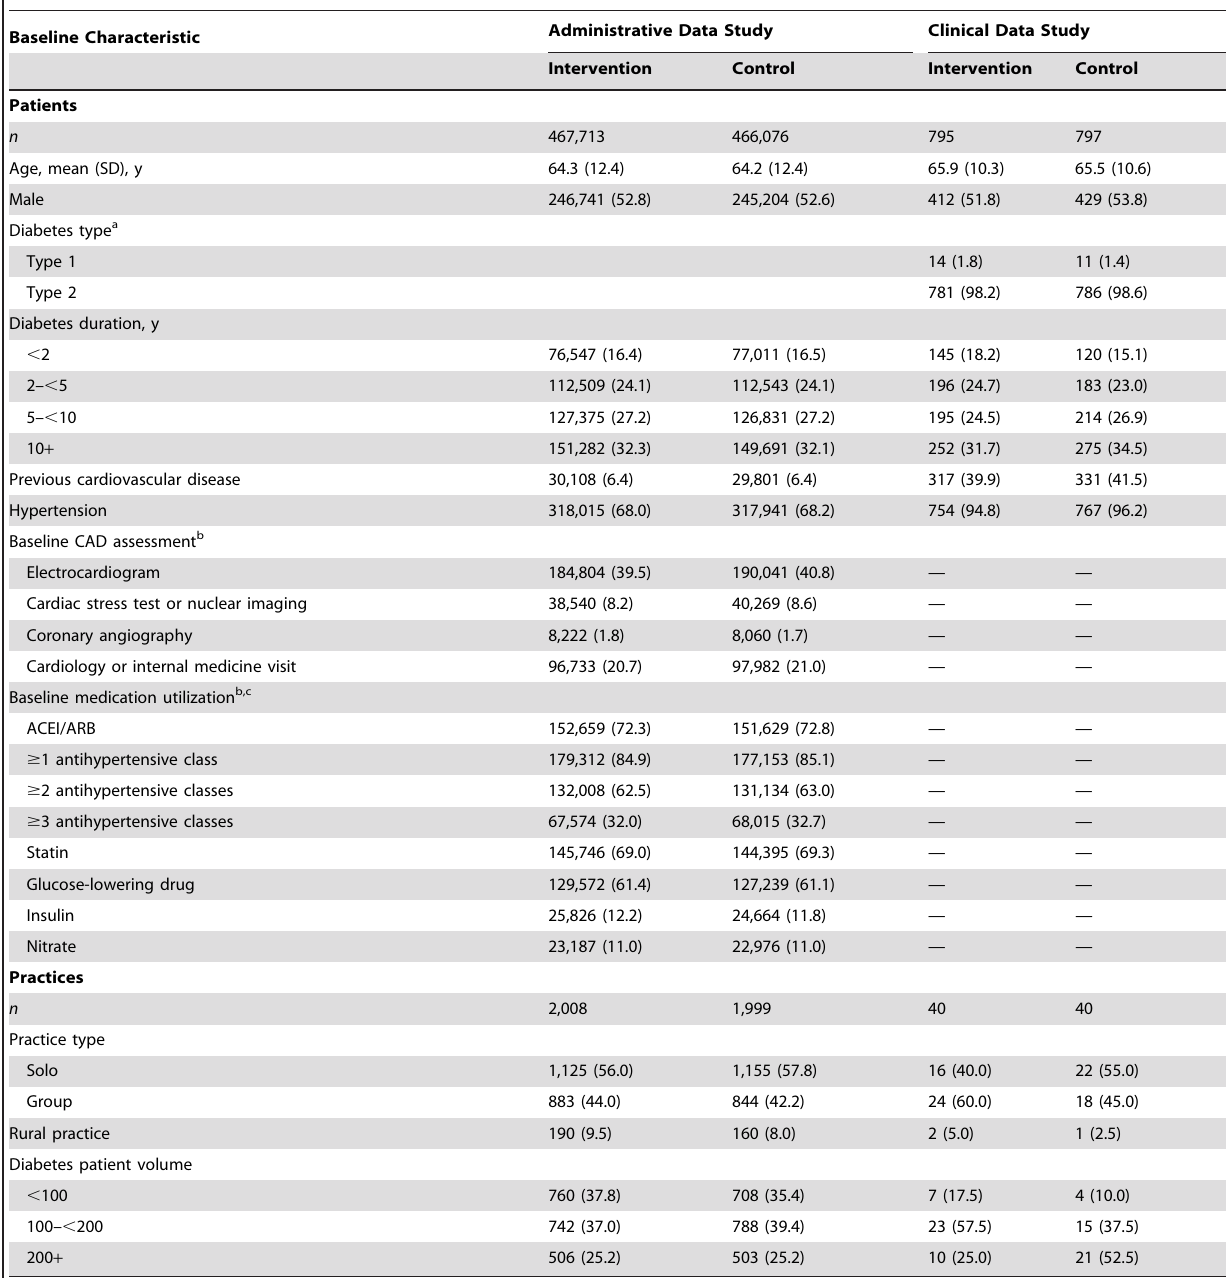
Table 1. Patient and practice baseline characteristics, by study